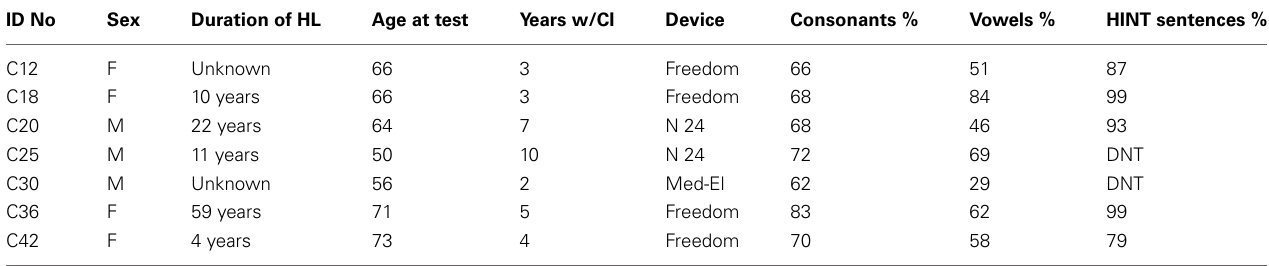
Table 1 | Demographic information about the CI